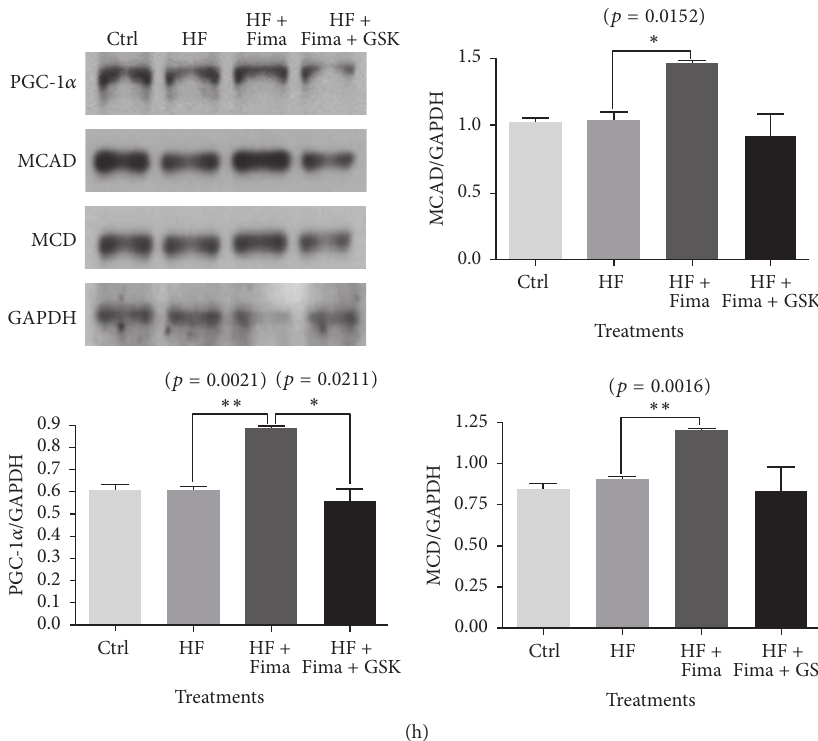
Figure 2: Peroxisome proliferator-activated receptor delta (PPAR 𝛿 ), 5 󸀠 adenosine monophosphate-activated protein kinase (AMPK), 11 beta- hydroxysteroid dehydrogenase type 1 (11 𝛽 -HSDH1), tumor necrosis factor-alpha (TNF- 𝛼 ), peroxisome proliferator-activated receptor gamma coactivator1-alpha(PGC-1 𝛼 ),mediumchainacyl-CoAdehydrogenase(MCAD),andmalonyl-CoAdecarboxylase(MCD)proteinexpression in HepG2 cells treated with high fatty acid and fimasartan. Protein extracts were electrophoresed in 10% polyacrylamide gel and blotted to nitrocellulose membrane. The nitrocellulose membrane was bound with primary and secondary antibodies sequentially, and then the chemiluminescent signal was exposed to X-ray film. The density of bands on X-ray film was analyzed with ImageJ program. The results are expressed as means ± SEM ( 𝑛 = 3 ). Values were statistically analyzed by unpaired t -test. All experiments were repeated three